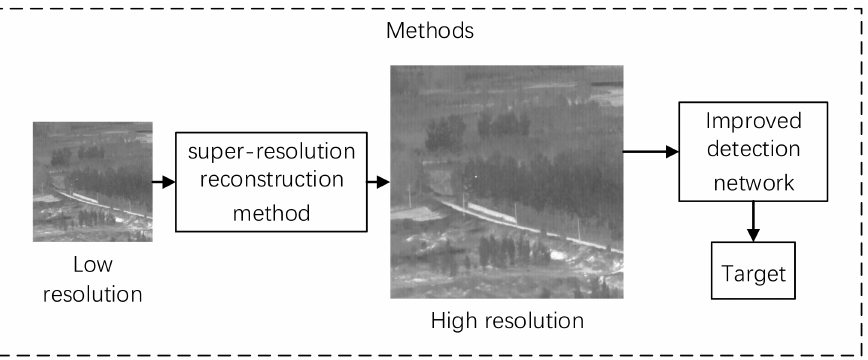
Figure 1. Target detection